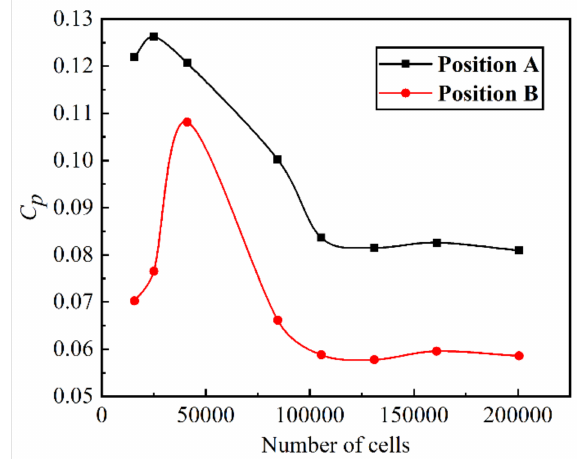
Figure 7. Mesh sensitivity